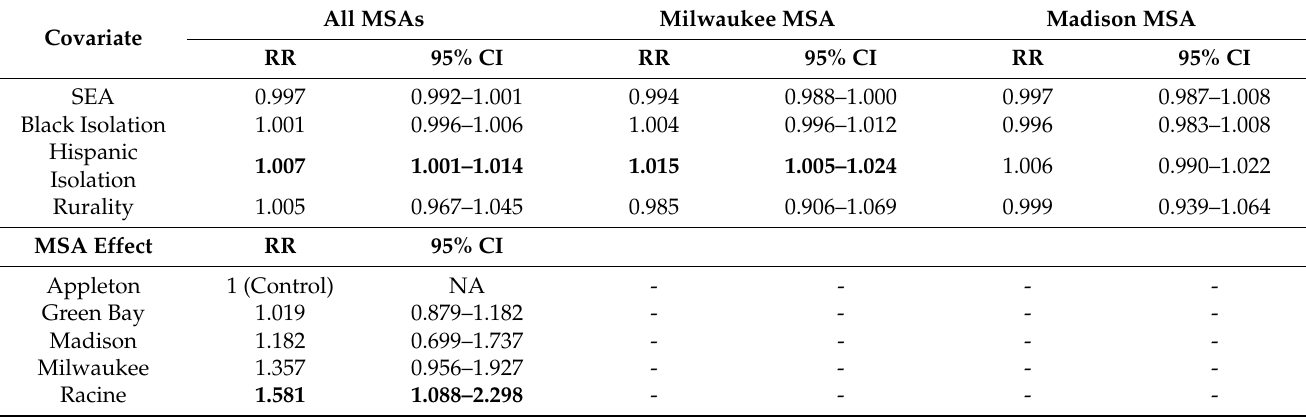
Table 2. Spatially adjusted log-linear regression models of liver cancer standardized mortality ratios. The first set of columns is the result of the pooled analysis across all five MSAs, which includes the fixed-effect coefficient for each MSA. The second and third set of columns are results of analysis limited to tracts within the Milwaukee and Madison MSAs respectively. Bolded coefficients are statistically significant predictors for p < 0.05. Abbreviations: RR: rate ratio for each covariate, CI: Confidence Interval, NA: Not